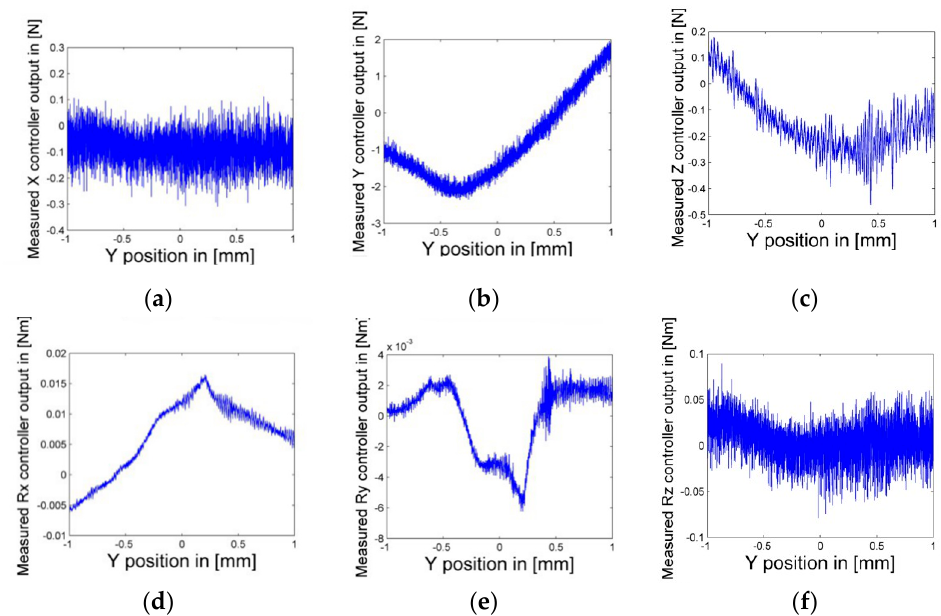
Figure 7. Recorded Short-Stroke (SS) controller forces: ( a ) X controller output, ( b ) Y controller output, ( c ) Z controller output, ( d ) Rx controller output, ( e ) Ry controller output, and ( f ) Rz controller output, with corresponding relative positions between the SS and the Long-Stroke (LS).